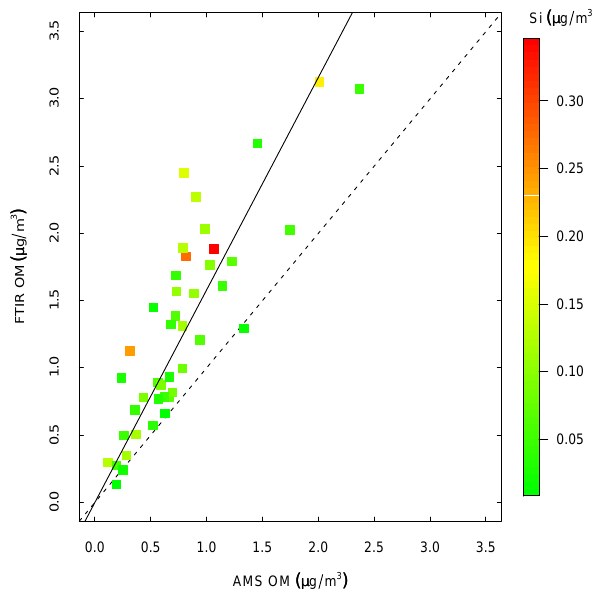
Fig. 1. Comparison of V mode HR- Tof-AMS and FTIR OM con- centrations. Five-minute resolution HR-Tof-AMS data was aver- aged over each filter sampling period and only filter periods in which the AMS was collecting measurements for at least 85% of the sample period (with a 50% duty cycle in V mode) were used here. 1:1 line is shown by a dashed line. Linear regression produces a fit through the origin with slope of 1.6 and r = 0 .